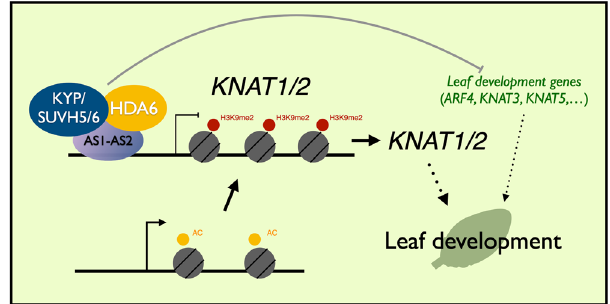
Fig. 8 A model for the KYP/SUVH5/6 function in the regulation of KNAT1/2 and leaf development genes. Arabidopsis KYP/SUVH5/6 are involved in leaf development by repressing KNAT1/2 . AS1-AS2 recruit HDA6-KYP/SUVH5/6 and act as transcription repressors of KNAT1/2 by altering H3Ac/H3K9me2 levels. KYP/SUVH5/6 plays an important role in leaf development by regulating the expression of KNAT1/2 and other leaf